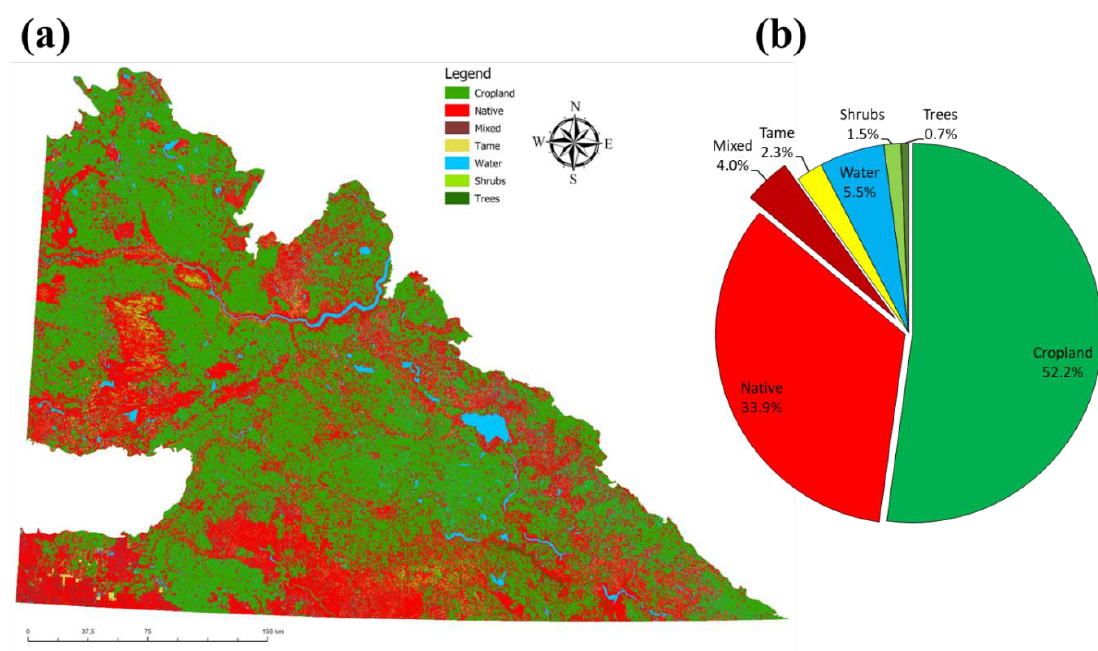
Figure 6. Quantification of the accuracy assessment depending on local ecologists using a spatial